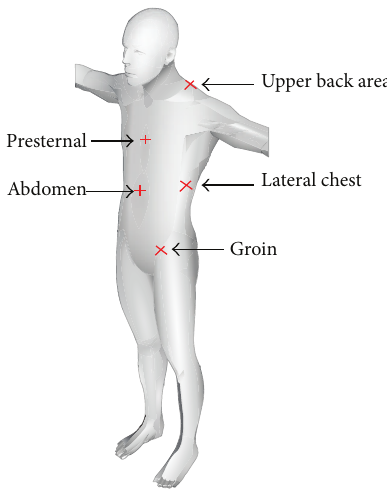
Figure 1: Topographic area on the trunk region where the skin sampleswereobtainedinhorizontalandverticaldirections(adapted from